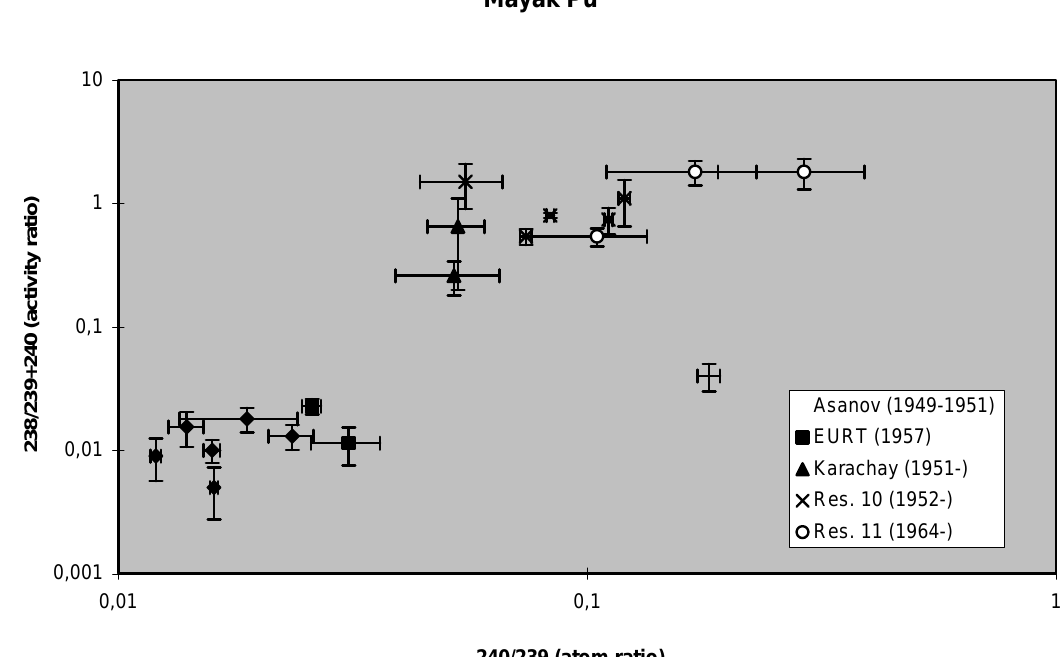
FIGURE 4. Two-dimensional plot of 240 Pu/ 239 Pu atom ratios and 238 Pu/ 239+240 Pu activity ratios in samples from Asanov (n = 6), EURT (n = 2), Karachay Groundwater (n = 2), and Reservoirs 10 and 11 (n = 8). GF = Global Fallout ratio are shown for